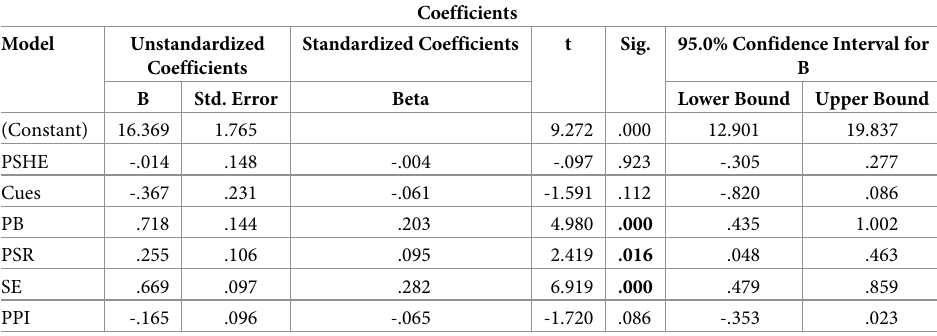
Table 8. Association between extracted factors and COVID-19 self-protective practice among secondary school students, Jimma, Oromia, Ethiopia, 2021 (n = 576). Coefficients Model Unstandardized